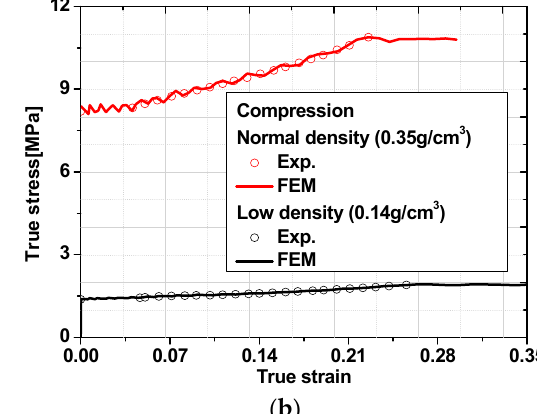
Figure 9. Constitutive curves for uniaxial damage in: ( a ) tension; ( b ) compression. Figure 10. Comparison of experimental and analysis results using concrete damaged plasticity model with respect to foam density in: ( a ) tension; ( b ) compression.